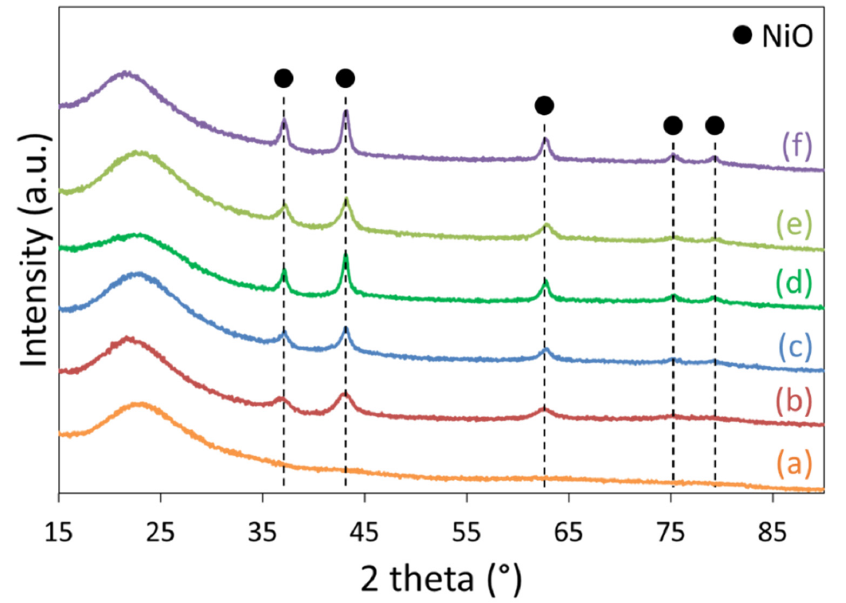
Figure 2. X-ray diffractograms of the calcined ( a ) Ni/SBA-15 HT (A), ( b ) Ni/SBA-15 com (N), ( c ) Ni/SBA-15 HT (N), ( d ) Ni/SBA-15 HT (Cl), ( e ) Ni/SBA-15(N), and ( f ) Ni/SiO 2 Table 1. Characteristics of the calcined, reduced, and spent catalysts.